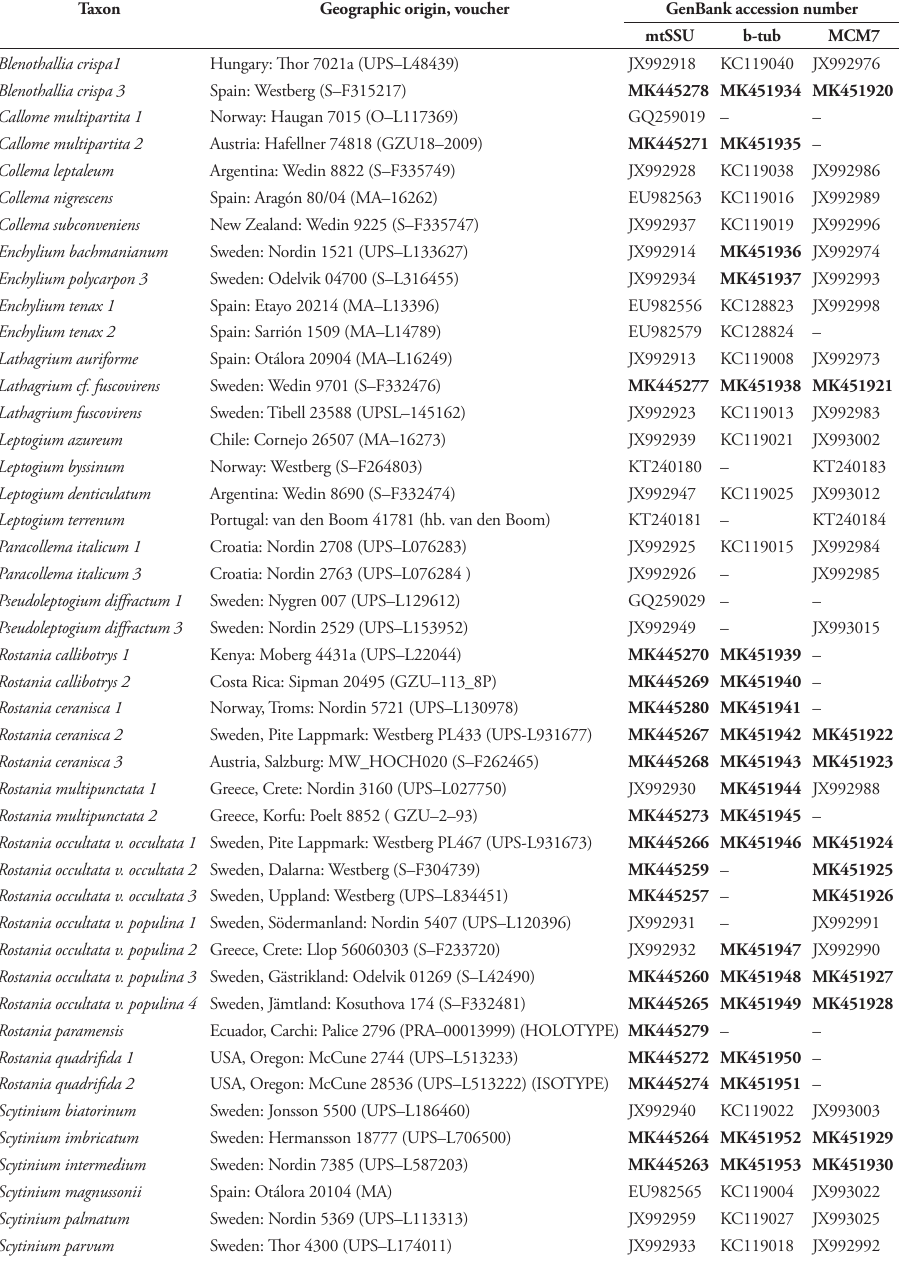
Table 1. Sequences utilized in this study (newly produced sequences in bold, remaining sequences pro- duced by Otálora et al. (2013a) and some of the outgroup sequences are taken from Wiklund and Wedin (2003), Buschbom and Mueller (2004), Otálora et al. (2010), Prieto et al. (2013)). In case of Rostania species, origin of both, state and provinces are